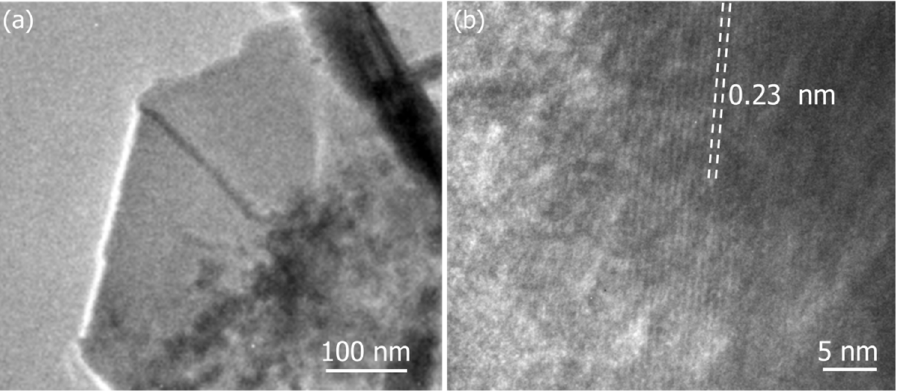
Figure 3. Typical ( a ) low-resolution and ( b ) high-resolution TEM images of the ZnCoO@NF nanosheets.